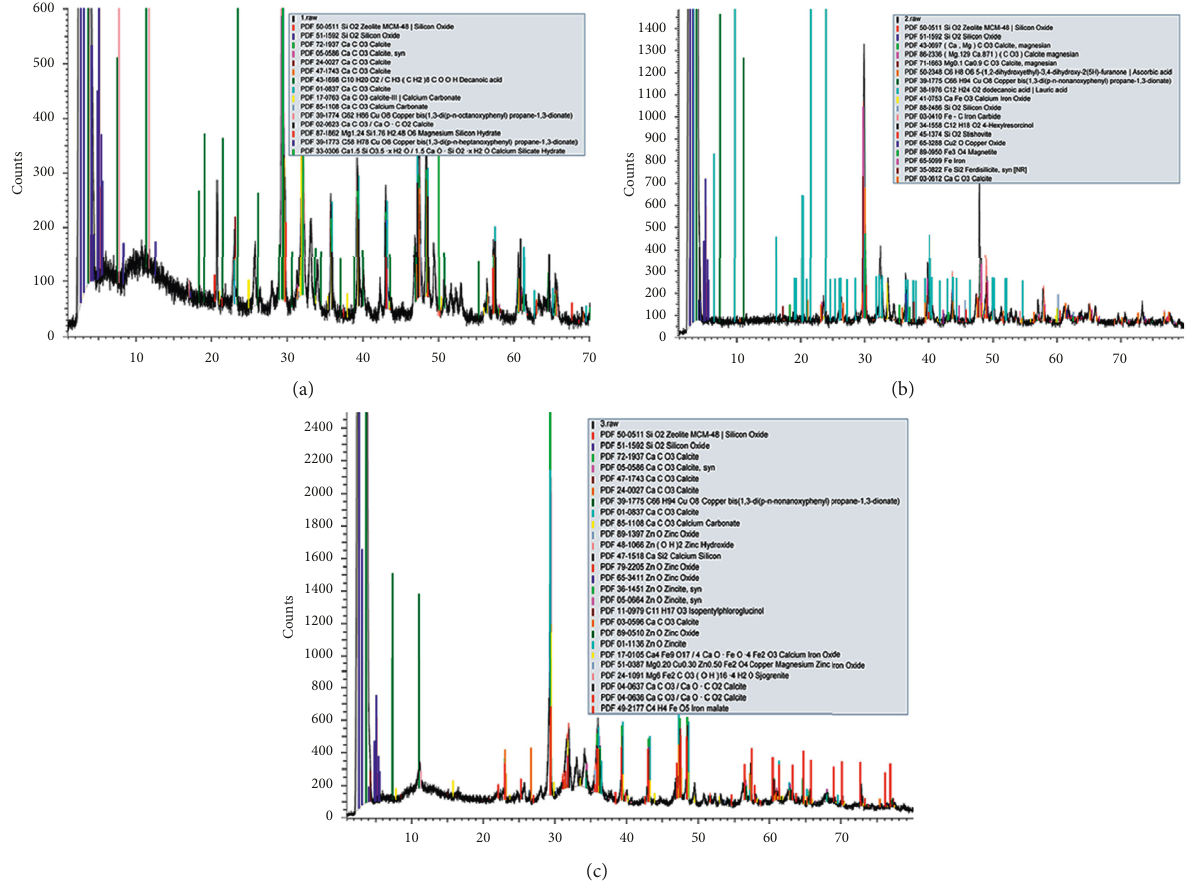
Figure 1: X-ray diffraction of (a) raw oil shale, (b) thermally activated oil shale, and (c) chemically activated oil